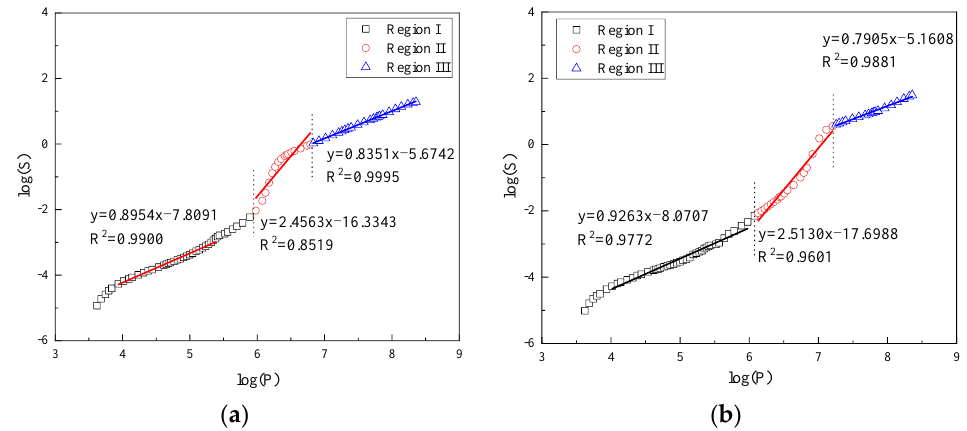
Figure 7. Multifractal characteristics of CCP10 at different ages under Neimark’s model. ( a ) 3 days, ( b ) 28 days.